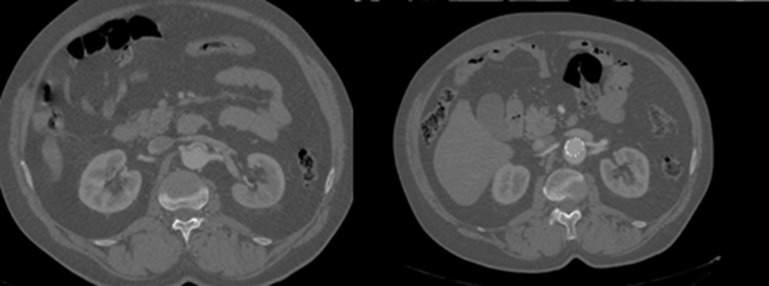
Comparison of preoperative and postoperative control tomographic images. In the postoperative image, the false lumen is maintained by retrograde refilling and the diameter of the true lumen has increased.